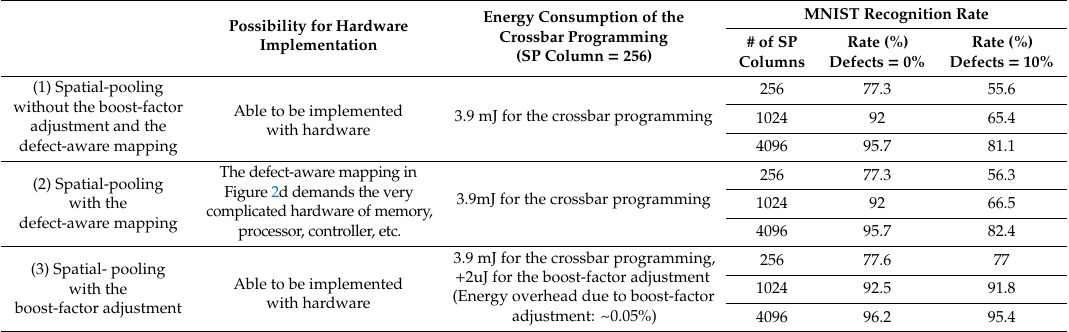
Table 1. Comparison of possibility of hardware implementation, energy consumption for the crossbar programming, and MNIST recognition rate for the three SP schemes. Here, SP means Spatial Pooler. Energy consumption is calculated during the training time of 10,000 MNIST